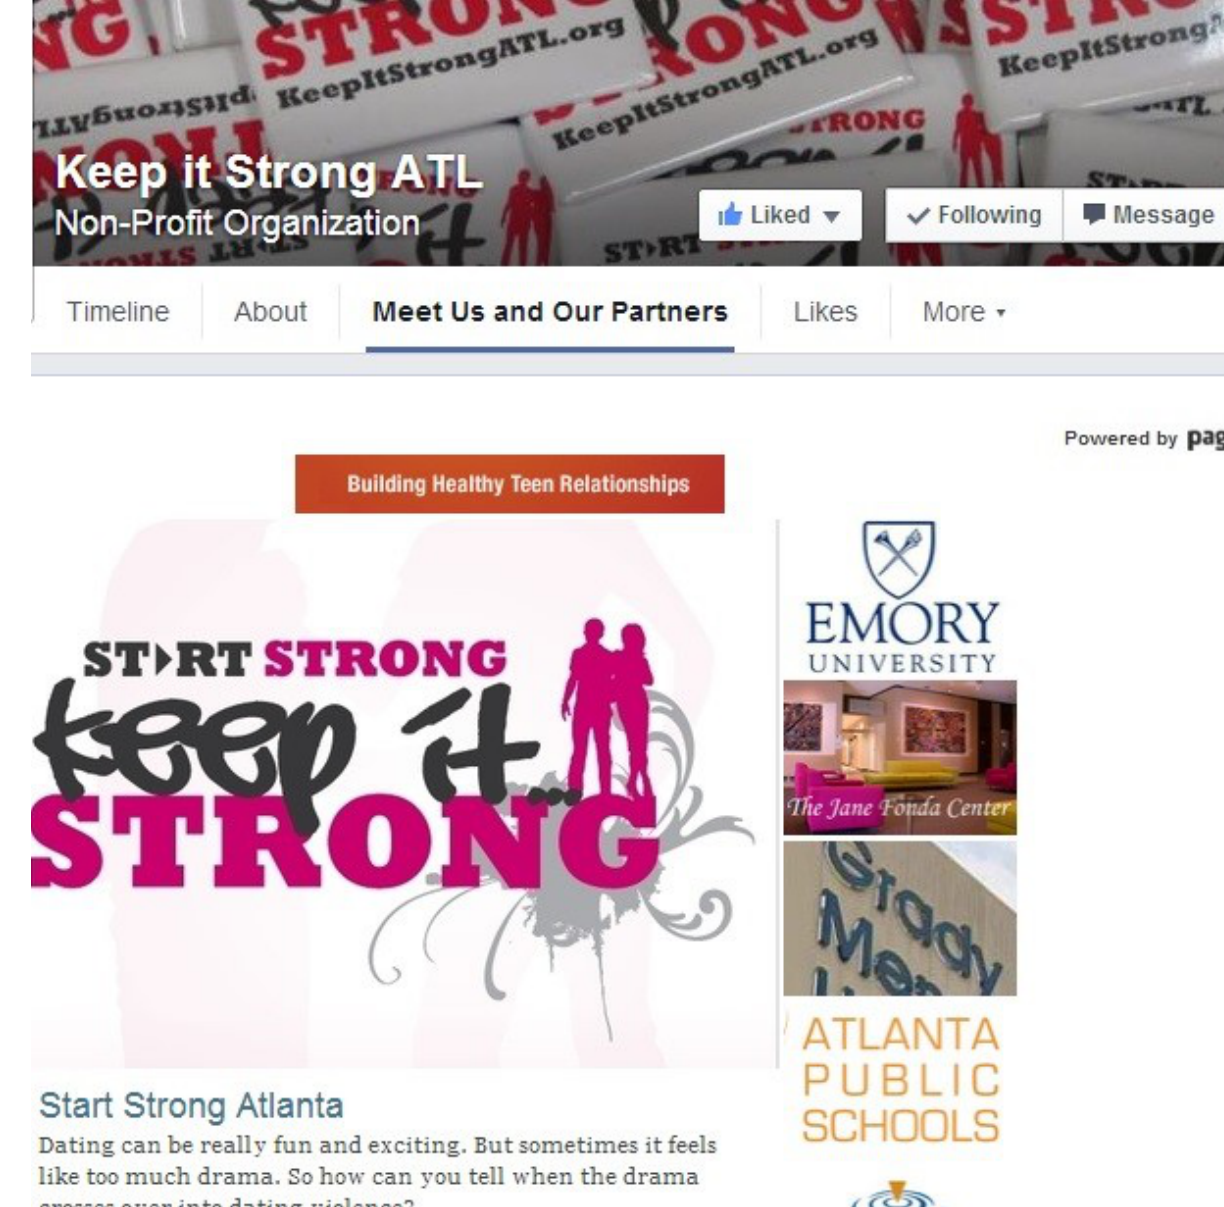
Figure 2. Start Strong ATL corporate Facebook